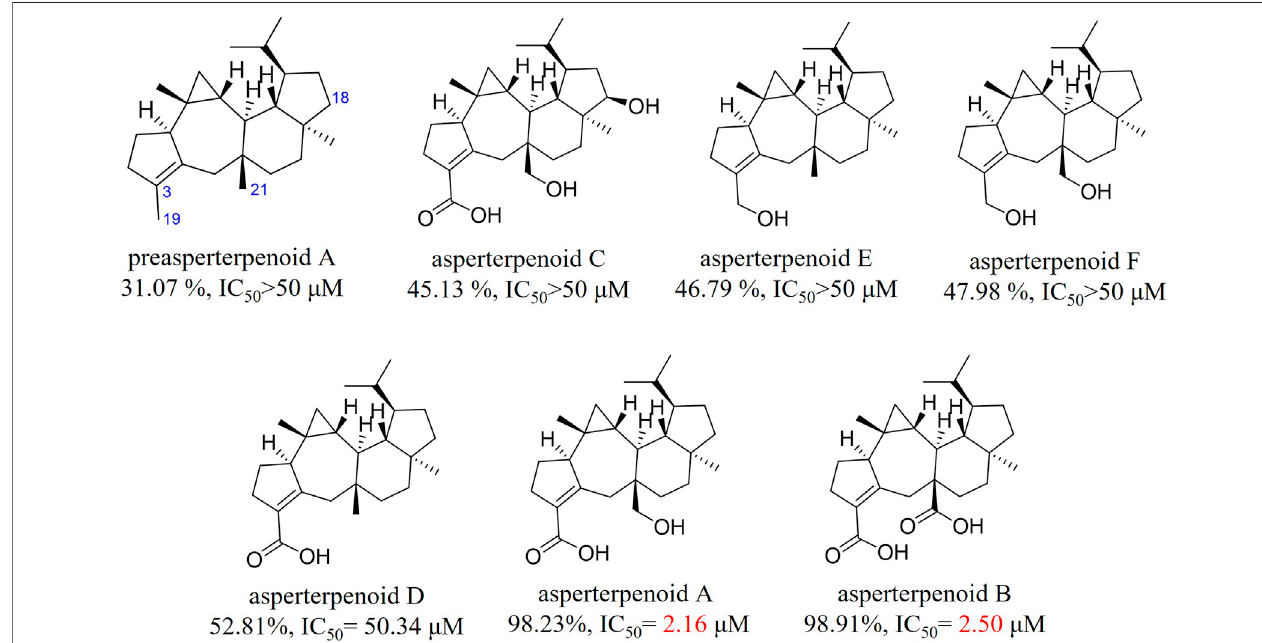
FIGURE 7 | m PTPB inhibition at 50 μ M and IC 50 value of